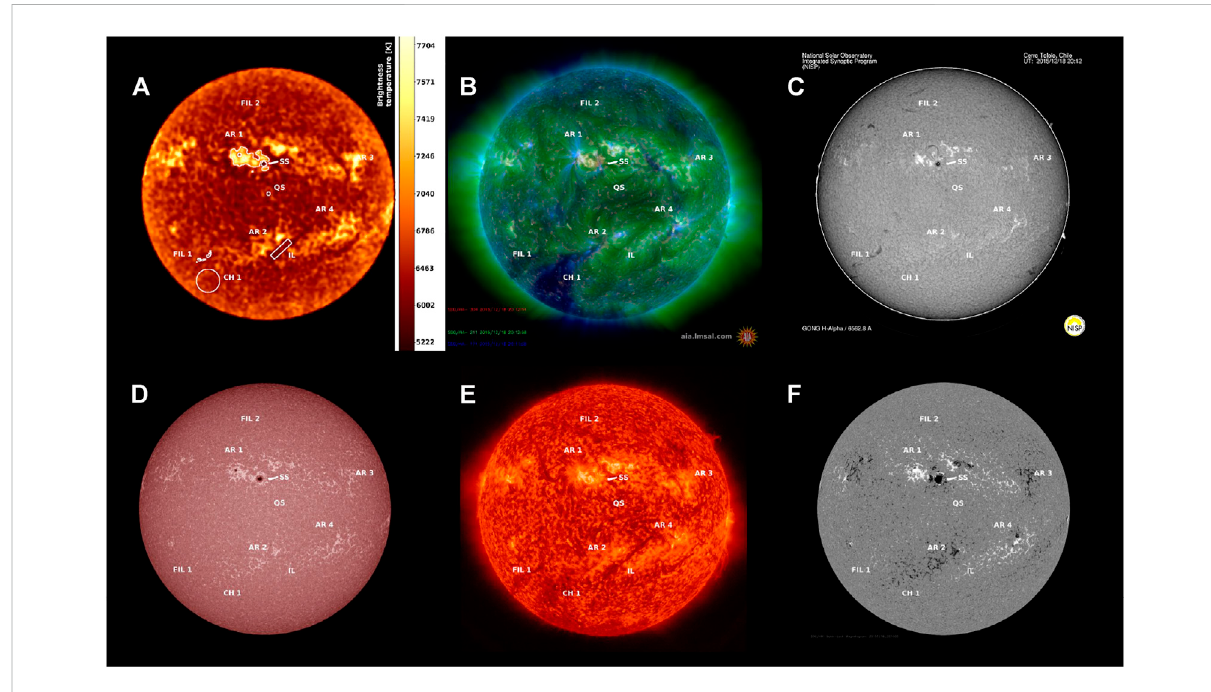
FIGURE 6 Images of the Sun from different instruments taken on 18 December 2015 (Top row) (A) : ALMA intensity map at 248 GHz ( λ = 1.21 mm, 20 h 12 m 21s). The brightness temperature in K is given on the intensity bar on the right. (B) : SDO composite image from AIA 30.4 nm, AIA 21.1 nm, AIA 17.1 nminstruments(20 h12 m58sUT). (C) :H α fi ltergramfromCerroTololoObservatory,NISP(20 h12 mUT). (Bottomrow)(D) :SDOAIA170.0 nm fi ltergram. (E) :SDOAIA30.4 nm fi ltergram. (F) :SDOHMImagnetic fi eld.Severalregionsofinterestareencircledbywhitelines:ARindicatesthe position of active regions, FIL shows the position of fi laments, SS shows the position of the sunspot, QS shows the position of the central quiet Sun region,ILindicatesthepositionofmagneticinversionline,whileCHisthepositionofthecoronalhole.AdaptedfromBraj š aetal.(2018).Reproduced with permission ⓒ